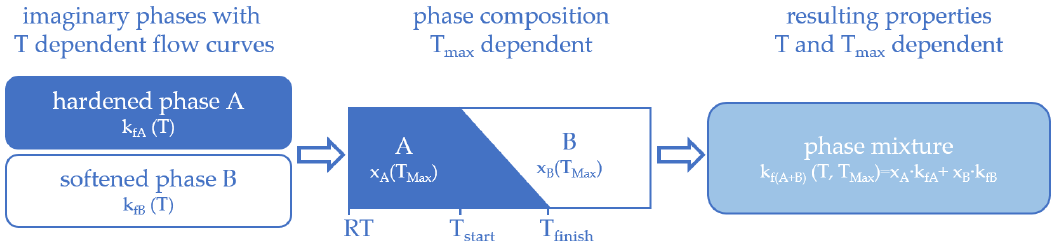
Figure 6. Schematic approach for an empirical-phenomenological material model of precipitation hardening aluminium alloys.